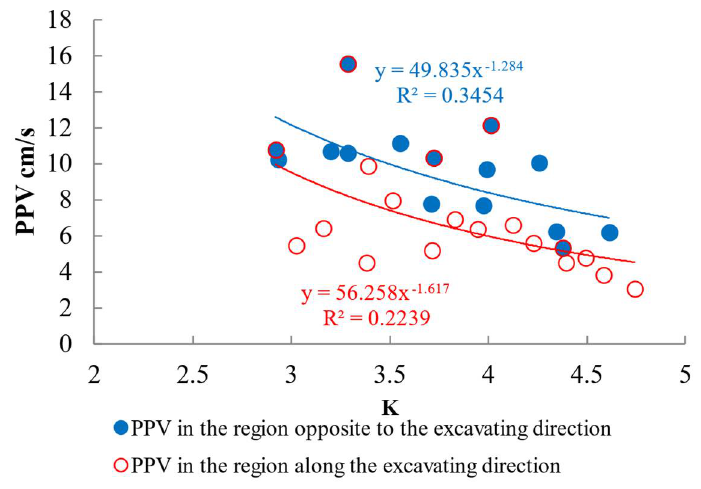
Figure 10. Relationship between the PPV and the scaled-charge weight.